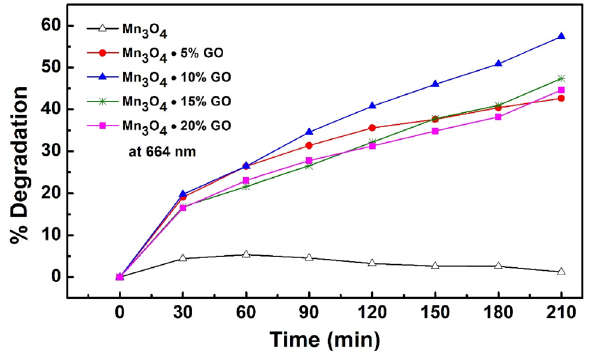
O and Mn O /x%GO NC’s (x = 0, 5, 10, 15, 3 4 3 4